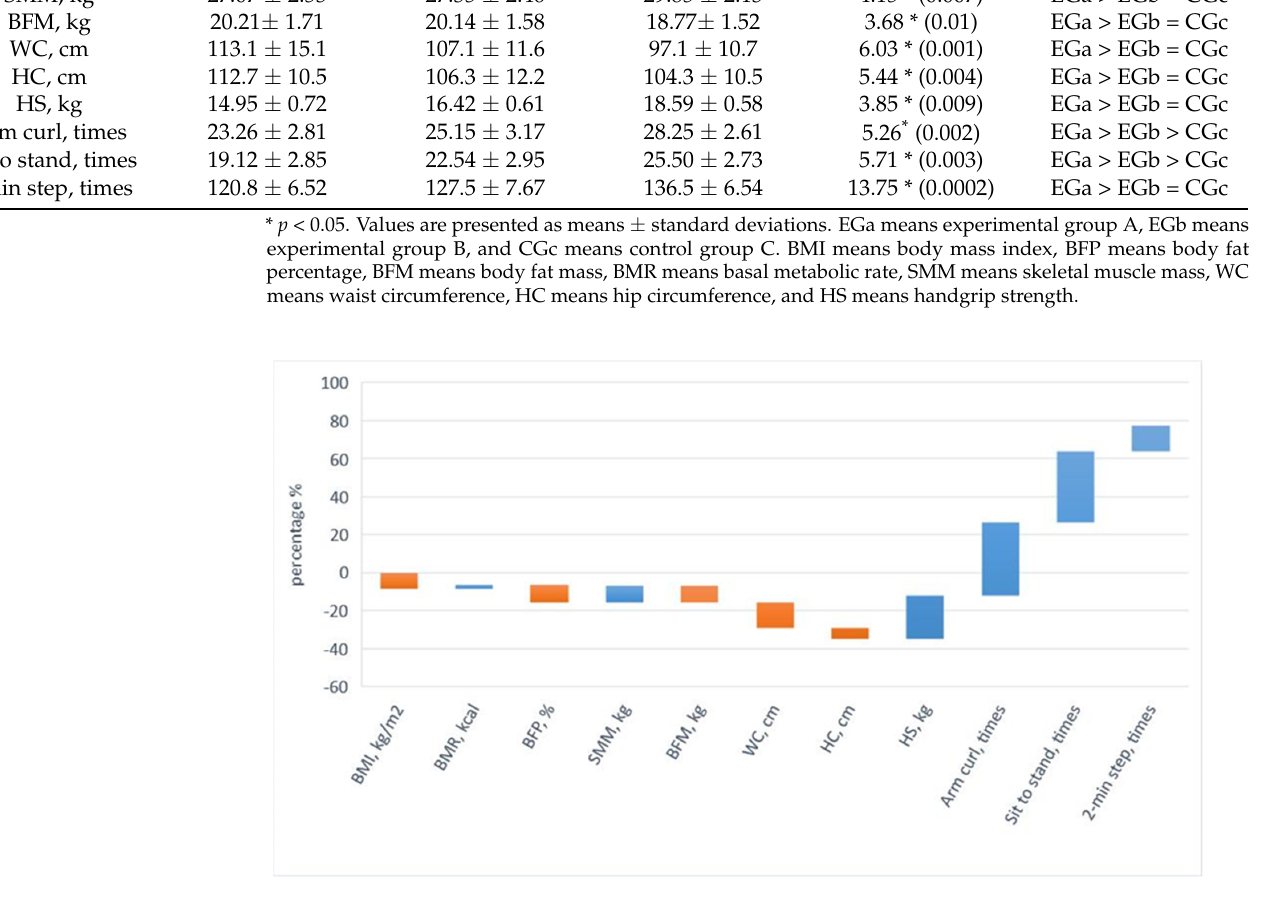
Figure 1. The EGa intervention results. Table 4. Descriptive statistics for the three experimental groups pre-test and post-test.